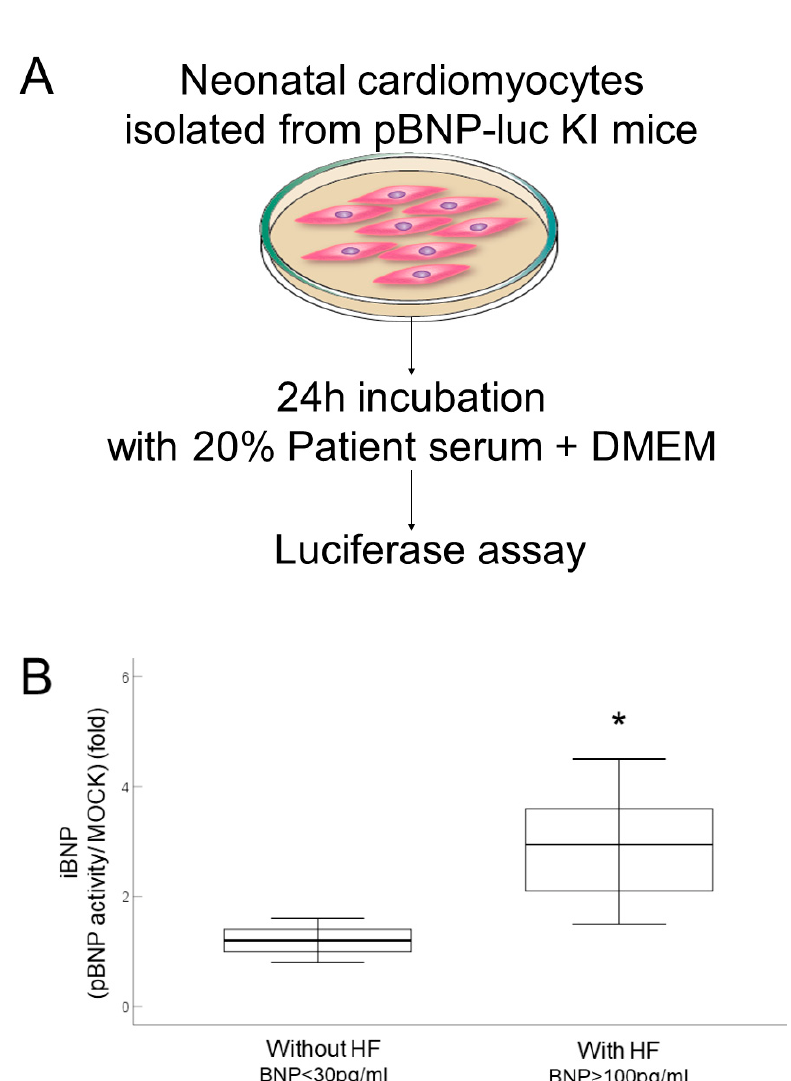
Figure 3. The BNP reporter system and activation of the BNP promoter in cardiomyocytes treated with serum from patients with heart failure. ( A ) Assay flow to measure serum-induced BNP (iBNP) expression. pBNP-luc KI mice, luciferase knock-in (KI) mice with site-specific integration of luciferase gene, which is regulated by, and acts as, an endogenous promoter of BNP (pBNP). DMEM, Dulbecco’s modified Eagle’s medium. ( B ) Box plot showing iBNP in cardiomyocytes from pBNP-luc KI mice stimulated with 20% serum from patients without, and with, heart failure (HF) for 24 h. n = 10. * p < 0.05 vs. without HF. BNP, brain natriuretic peptide; DMEM, Dulbecco's Modified Eagle Me- dium.